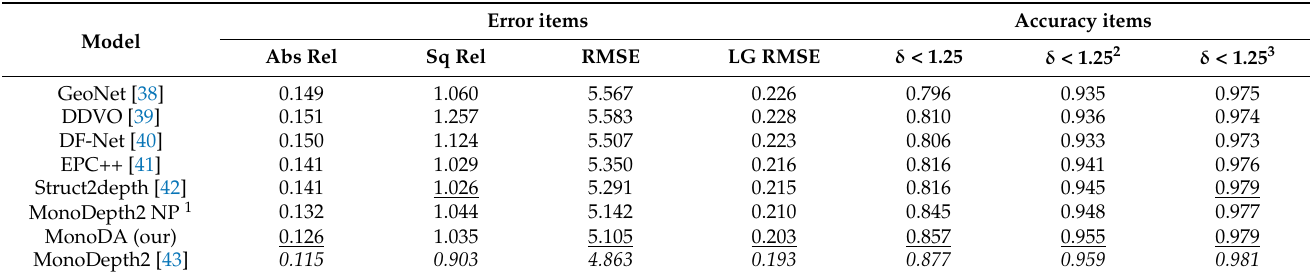
Table 2. The evaluation results of several monocular depth estimate models over